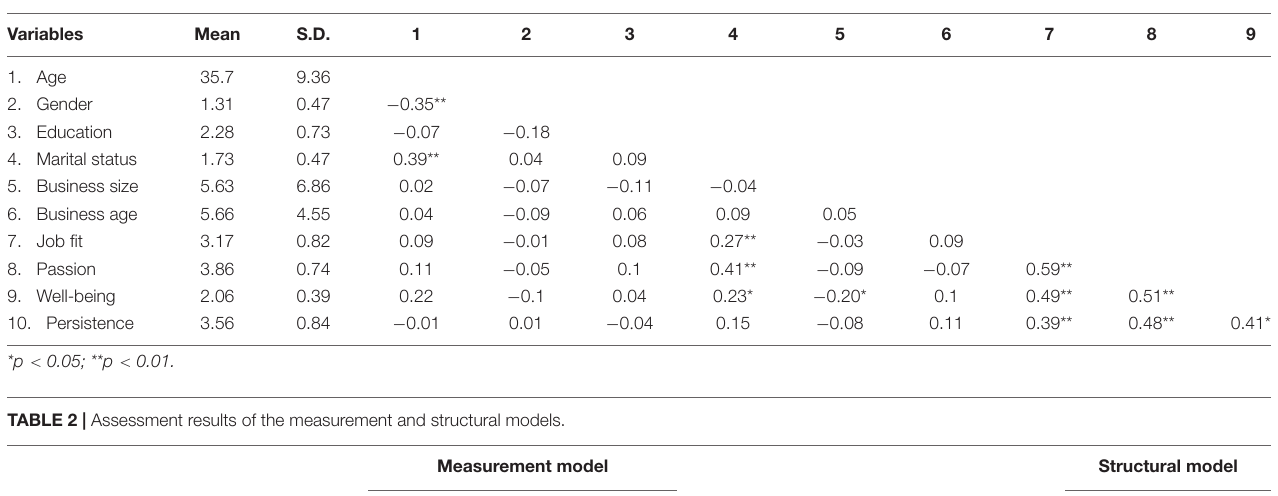
TABLE 1 | Means, standard deviations, and correlations among variables.